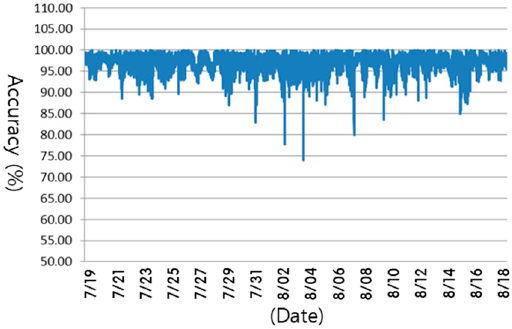
Figure 14. Daily accuracy results for the target illuminance.